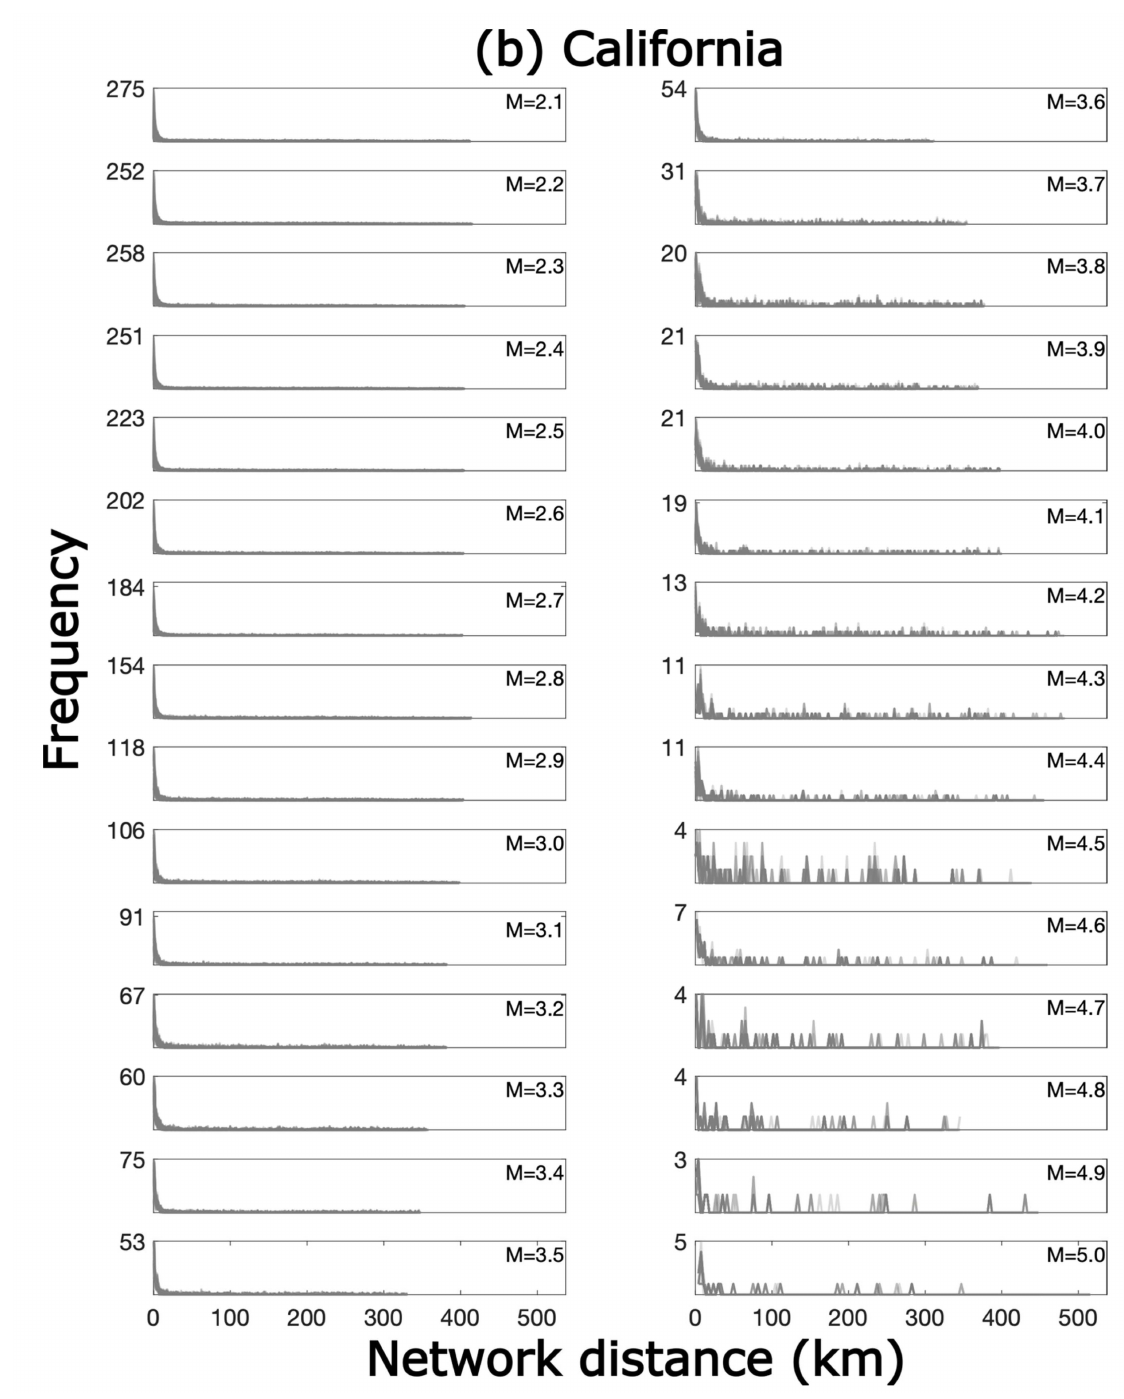
Figure 3. Frequency of the network distance in different magnitude bins, as labeled at the top right corner of each panel for ( a ) Taiwan and ( b ) California. The tick of the y axis shows the maximum